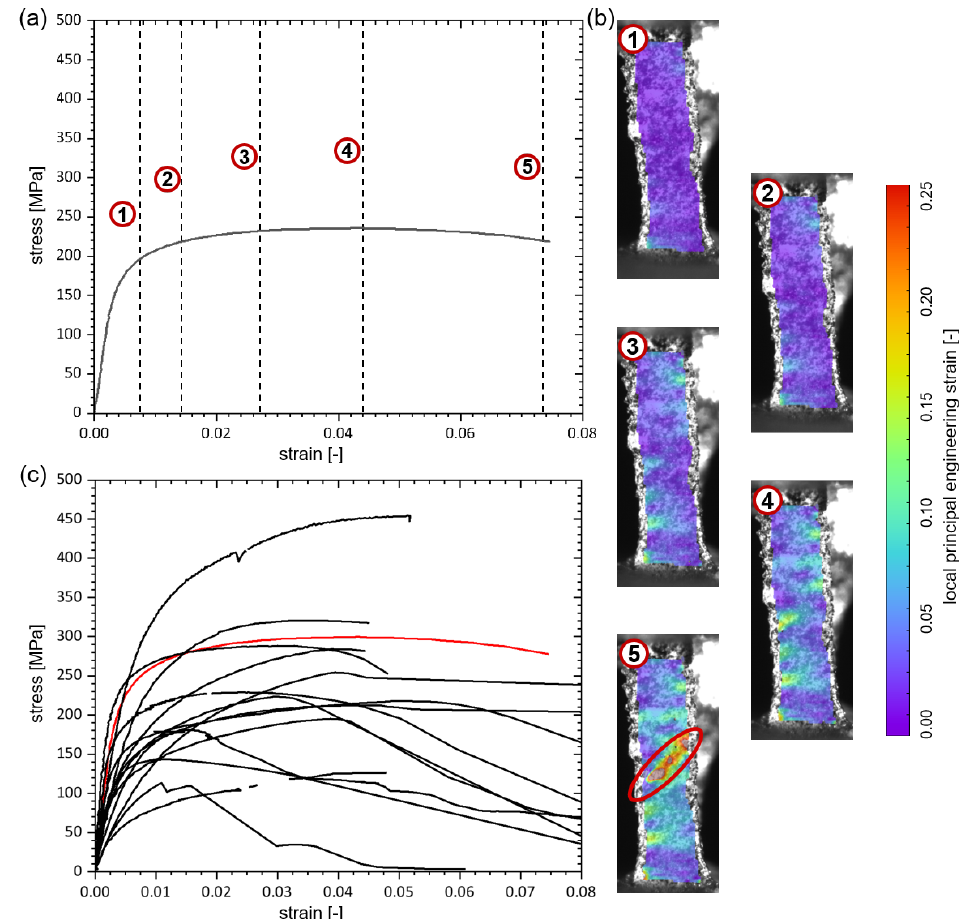
Figure 6. Results of 18 microtensile tests on Ni/PU hybrid foam struts: ( a ) exemplary stress-strain-diagram with five marked positions, ( b ) DIC results for the five marked positions in ( a ) with the crack highlighted (red ellipse) in the last step, ( c ) stress-strain-diagrams for all 18 struts, with the exemplary strut highlighted in